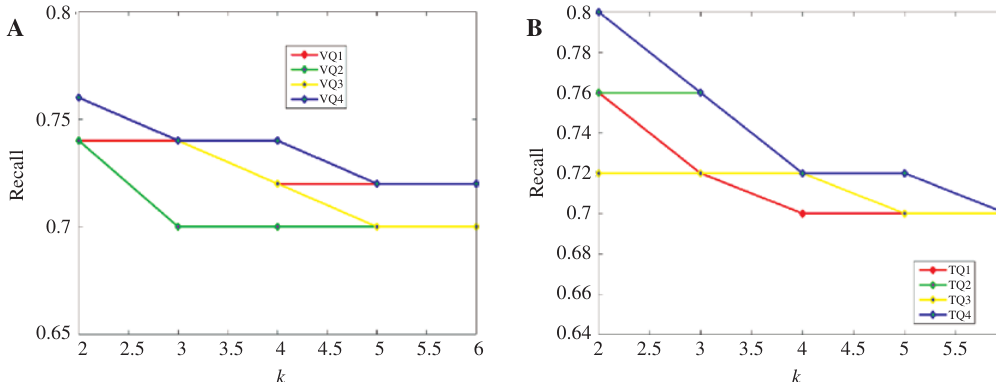
Figure 7: Recall Graph.